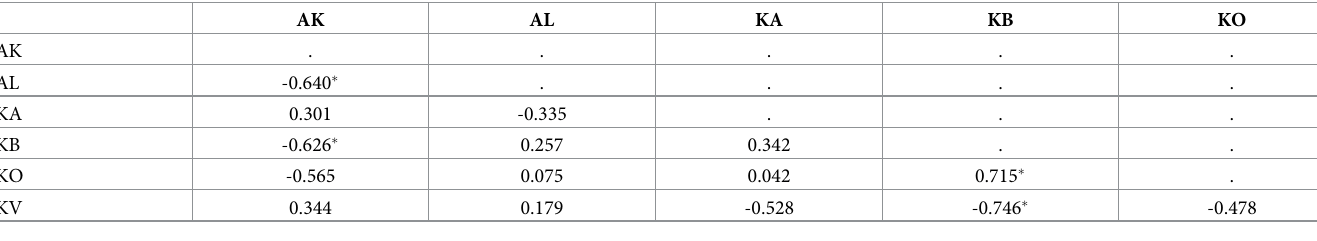
Table 1. Pearson correlation index for averaged YM2 in six environments.